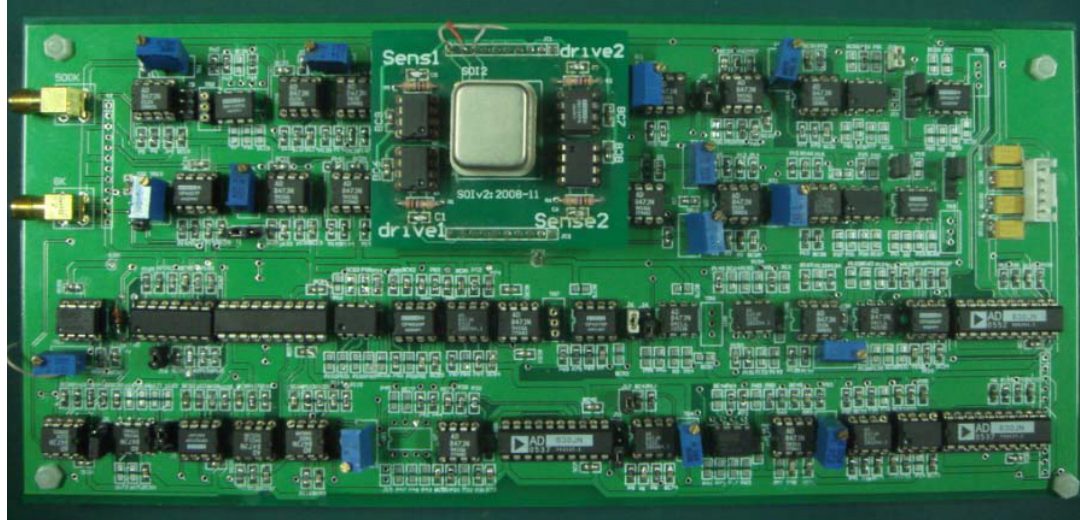
Figure 14. Photo of a test circuit board for